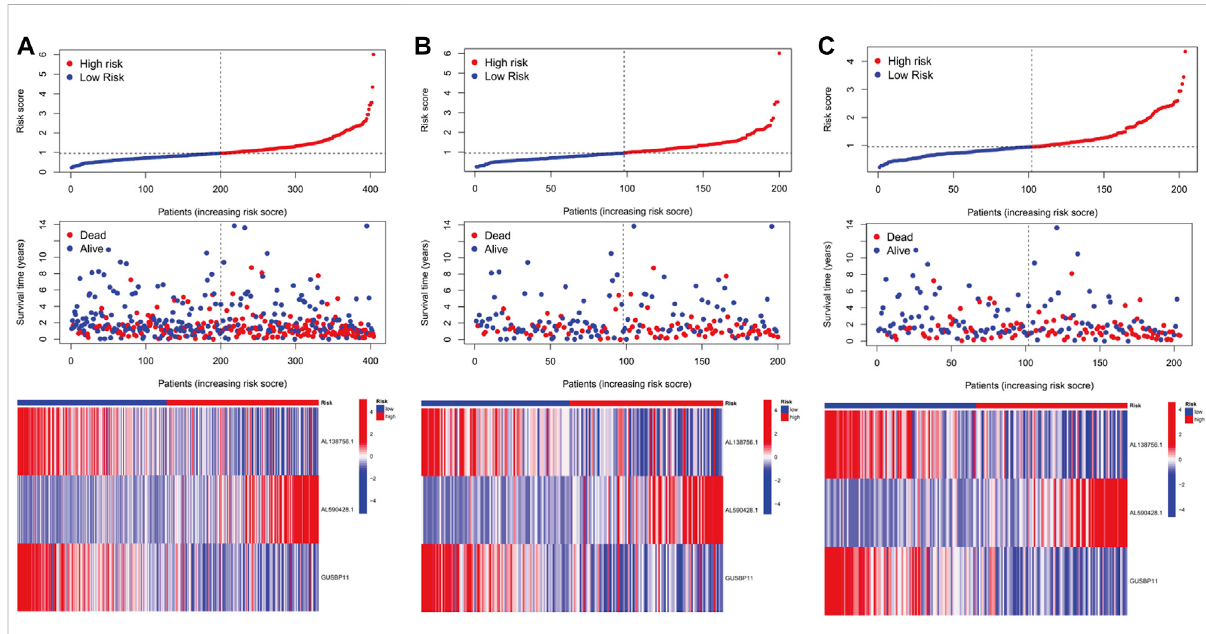
The predictive performance of characteristics. Distribution of risk score, status and the expression of prognostic CRLs in the all group (A) , training group (B) , testing group (C)